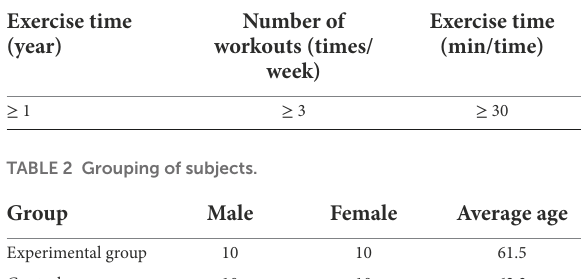
TABLE 1 Silver hair square dance exercise standard.